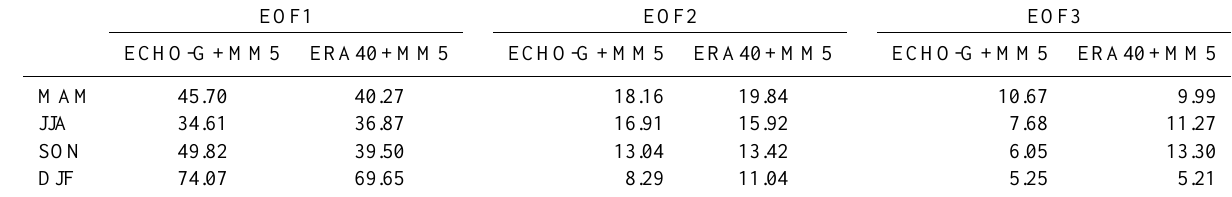
Table 2. Percentage of variance explained by each EOF of the seasonal mean series of precipitation.